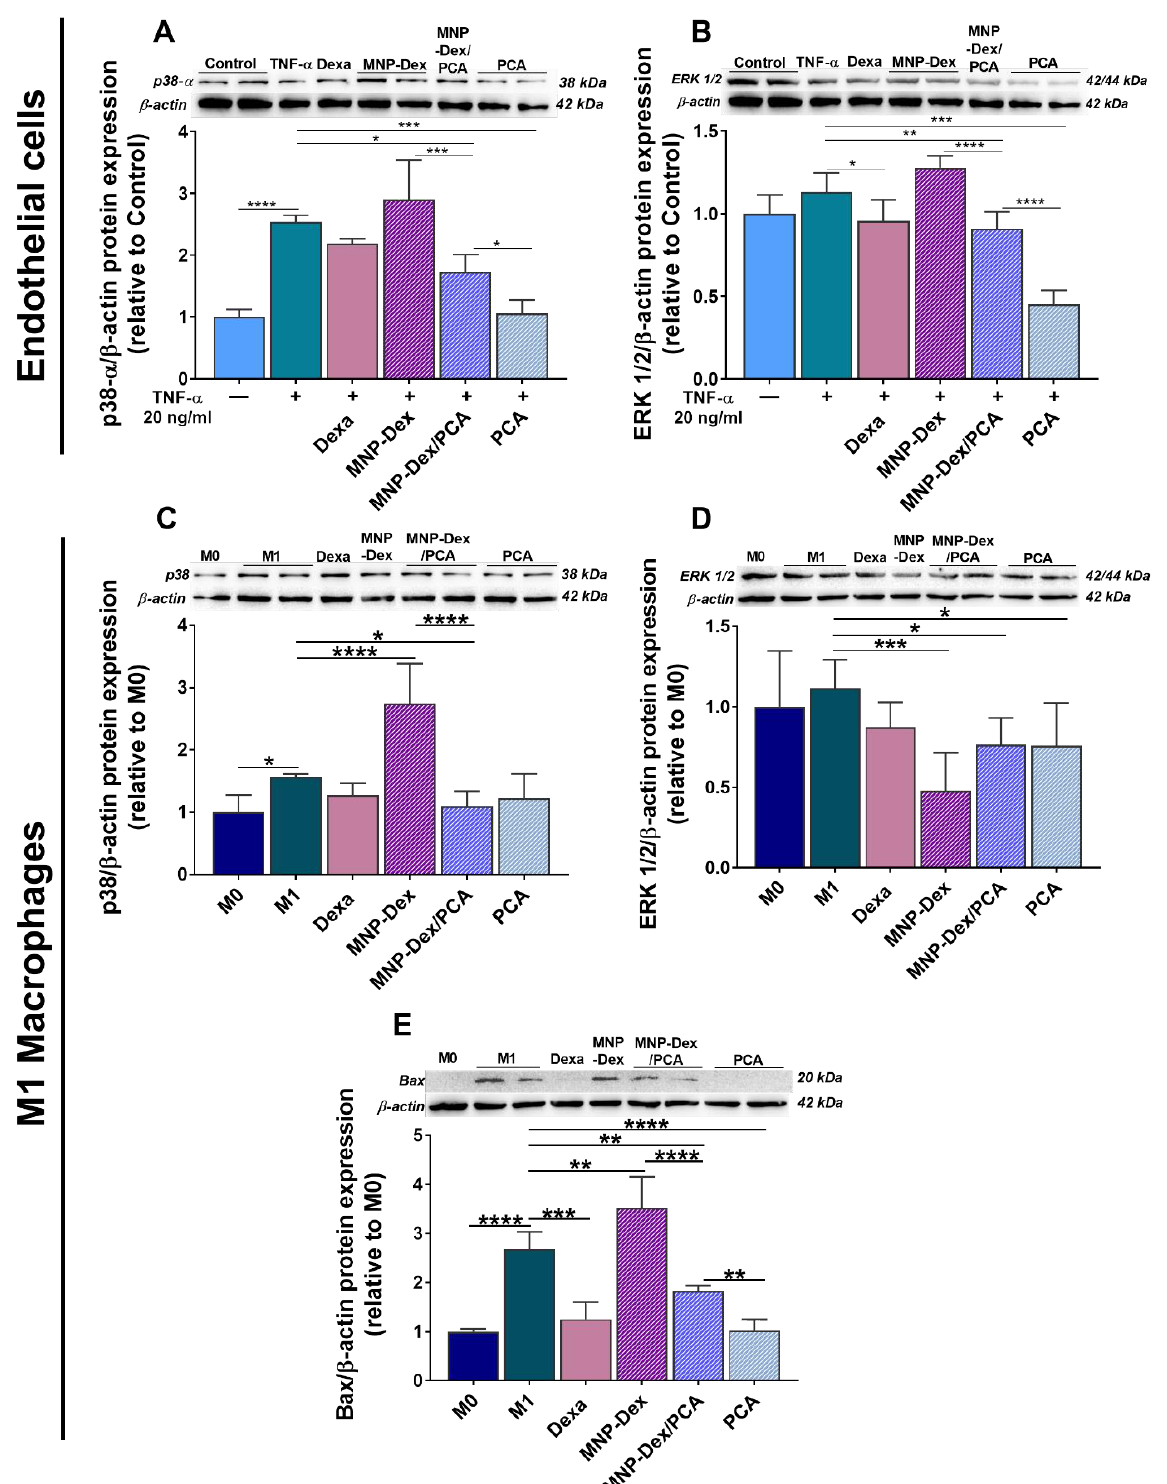
Figure 6. Protein expression of p38- α ( A , C ) and total ERK 1/2 ( B , D ) in quiescent (-) and TNF- α (20 ng/mL)-activated (+) EA.hy926 cells and M1 macrophages after 48 h of incubation with MNP-Dex/PCA (62 µ g/mL MNP/ 350 µ M PCA), as well as the protein expression of anti-apoptotic molecule Bax in M1 macrophages ( E ). Plain MNP-Dex, free PCA, and dexamethasone (Dexa) were used as controls. Protein expression was normalized to β -actin. The data are expressed as mean ± SD from three independent experiments. * p < 0.05, ** p < 0.01, *** p < 0.001, and **** p < 0.0001.